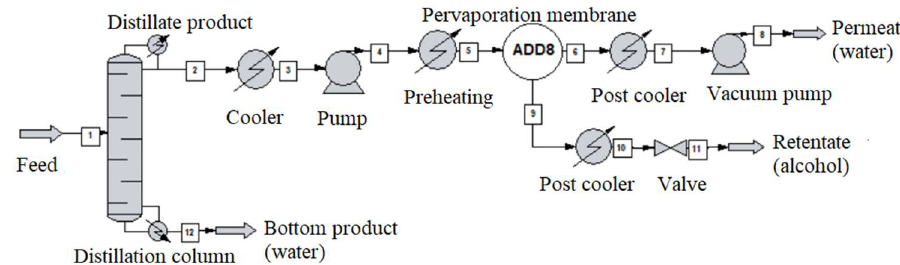
Figure 8. Flowsheet of hybrid distillation-hydrophilic pervaporation method.